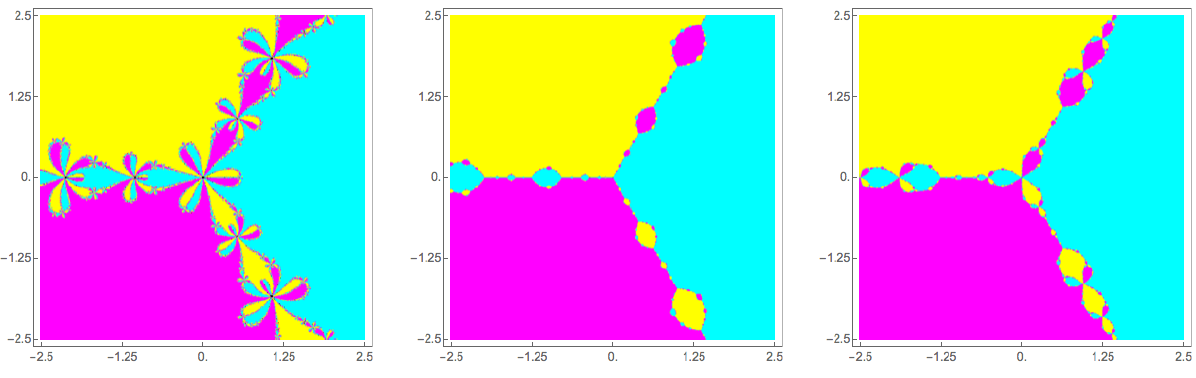
Figure 2. Basins of attraction of the Chebyshev, Halley and super-Halley methods ( α = 0 , α = 1 / 2 and α = 1 , respectively, in Equation (19)) applied to the polynomial p ( z ) = z 3 − 1